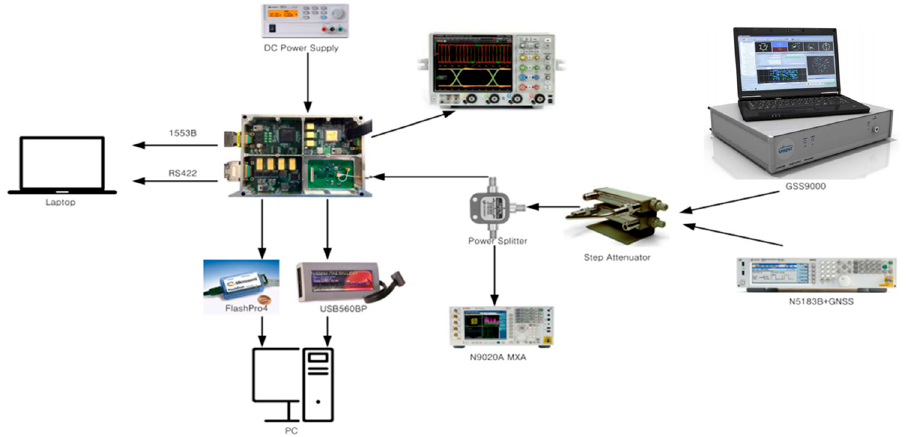
Figure 3. Test configuration using a GPS simulator to verify the performance of GPS-12.